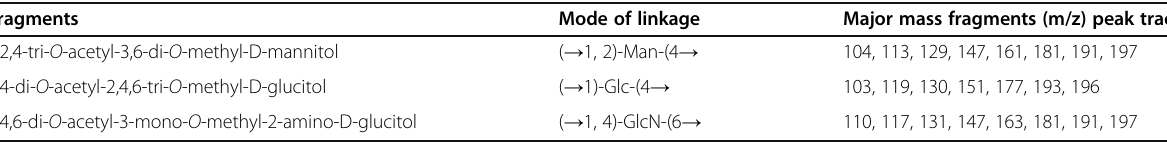
Table 3 GC data showing the number of peak traces Fragments Mode of